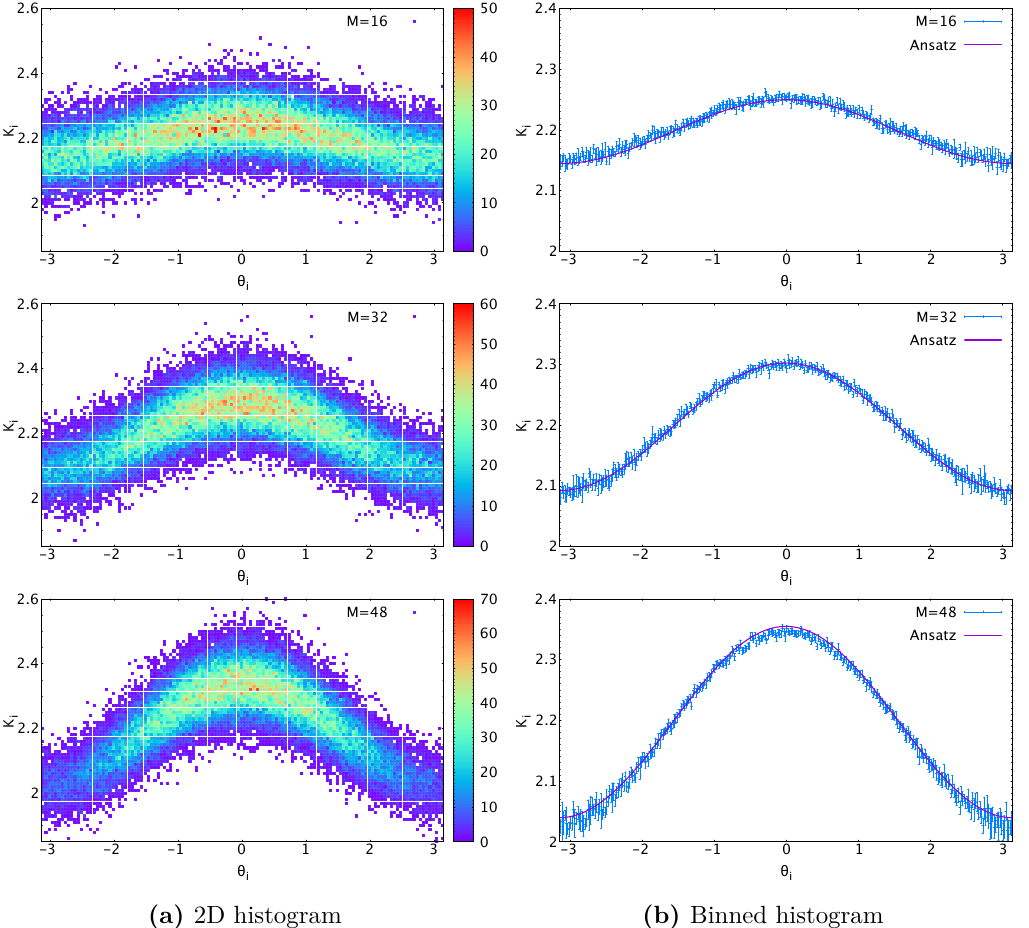
Figure 12. Yang-Mills matrix model, θ i vs K i , N = 64 , L = 64 , and T = 0 . 885 . The total number of data points for each M is obtained by 64 × (# config.) in table 2. The center symmetry is fixed sample by sample such that P = | P | . (a) The two-dimensional histograms of ( θ i , K i ). (b) The averaged K i within the narrow bin ∆ θ = 0 . 02 . The magenta lines are fit based on eq. (4.9), by using the best-fit values r 0 = 2 . 197 and r 1 = 2 . 302 . The values obtained by the fits are consistent with the values of the variances in table 2. The error bars in each figure are obtained by jackknife